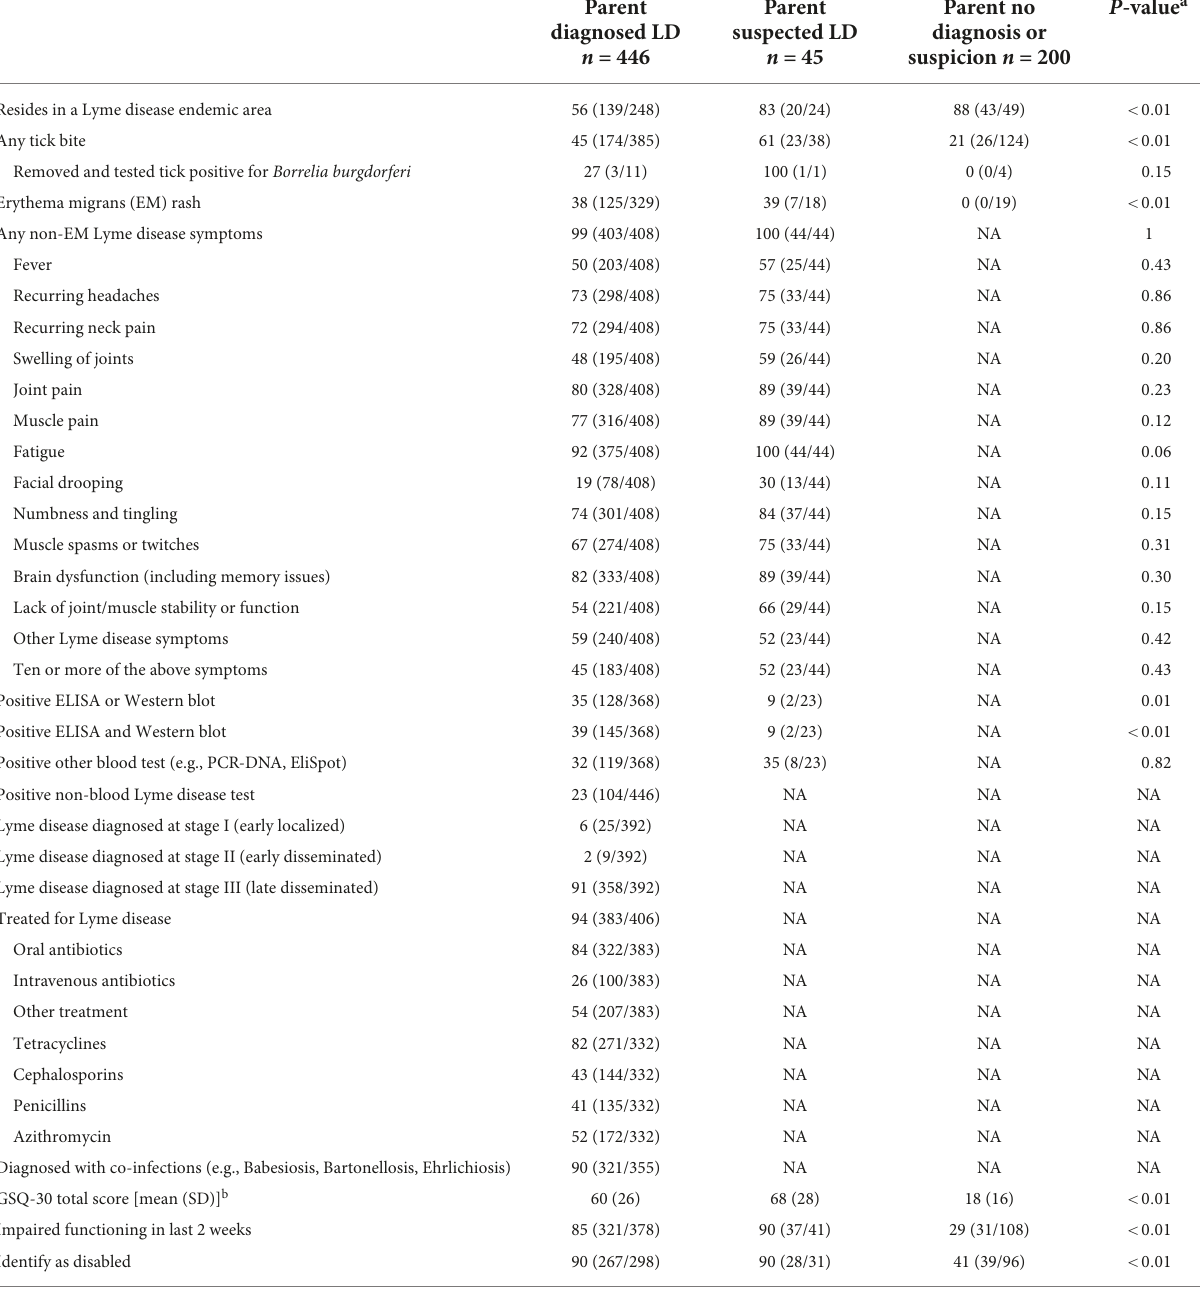
TABLE 2 Participant/birthing parent Lyme disease symptoms, testing, and treatment.